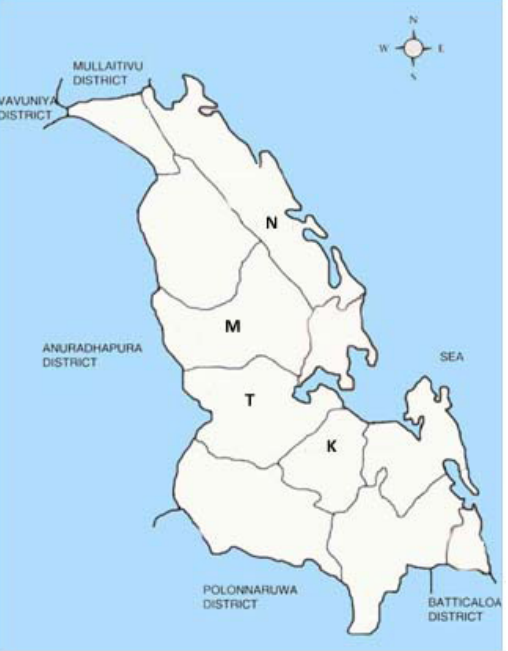
Figure 1: Sample collection sites. Butternut squash fruit rot samples were collected from four different regions (N - Nilaveli, M - Morawewa, T - Thambalagamam and K - Kinniya) in Trincomalee